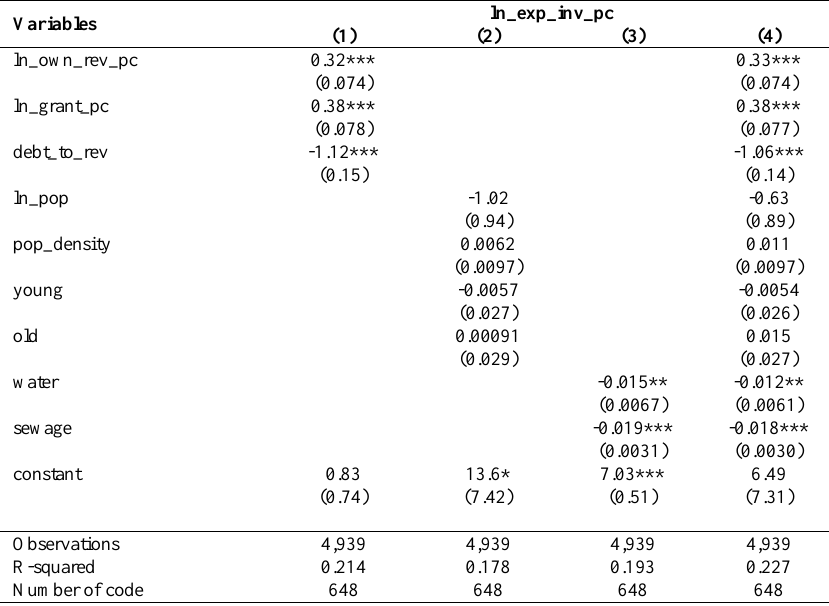
Table 6. Fixed effects (FE) regression results for municipalities with up to 5,000 inhabitants in the years 2007–2013